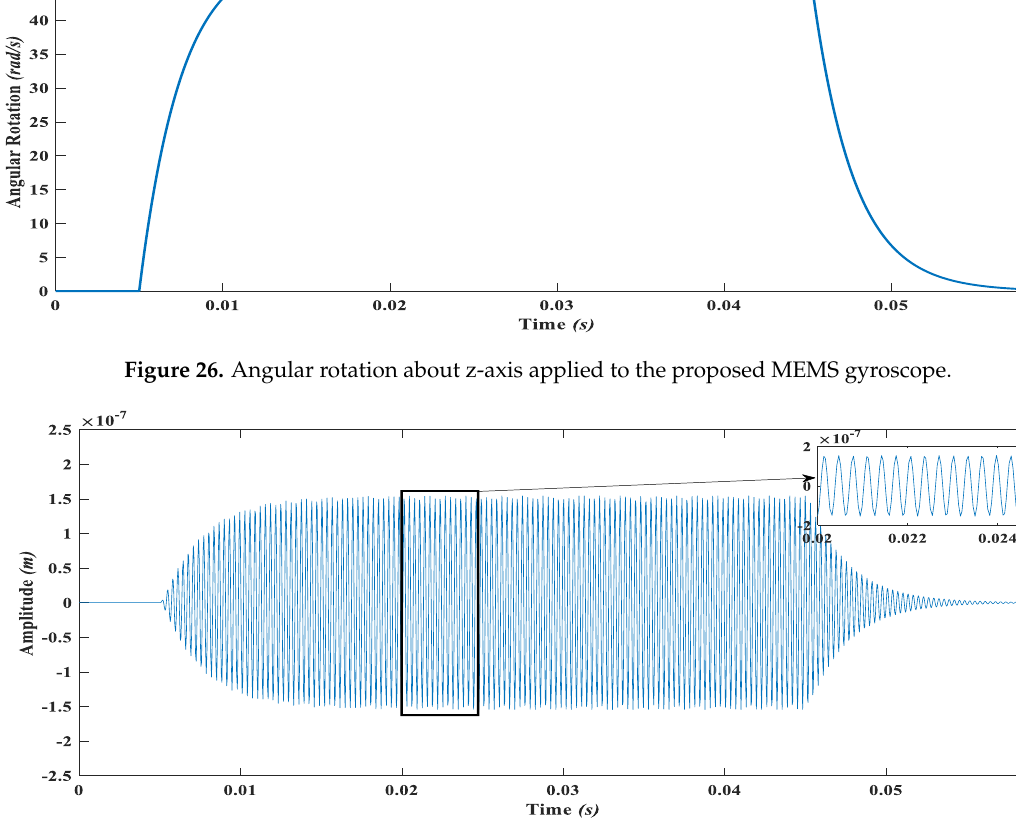
Figure 27. Sense mass displacement amplitude in the y-axis due to induced Coriolis force.